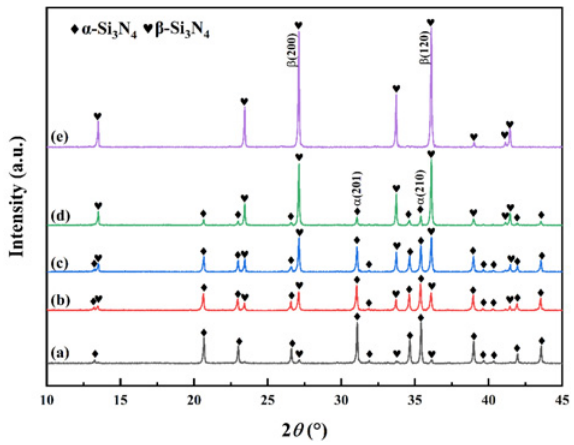
Fig. 1 XRD patterns of Si 3 N 4 ceramics: (a) SN1500, (b) SN1600, (c) SN1650, (d) SN1700, and (e)